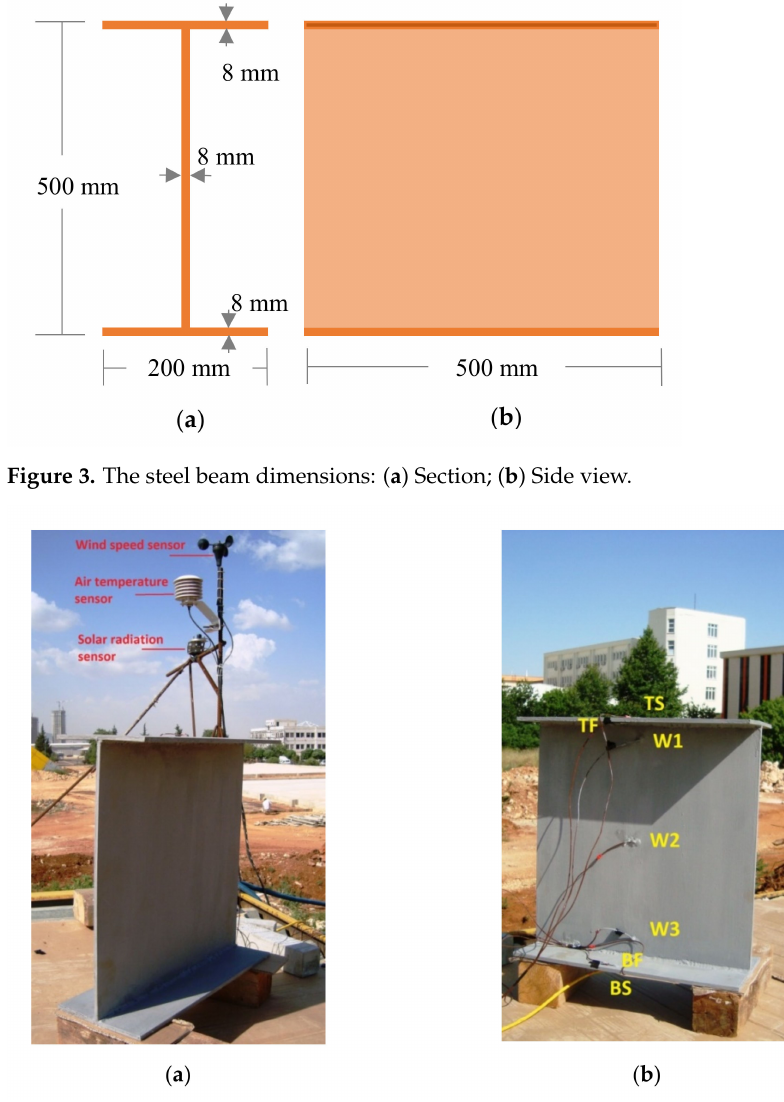
Figure 4. The experimental steel beam: ( a ) Southern view and thermal loads sensors; ( b ) Northern view and thermocouple